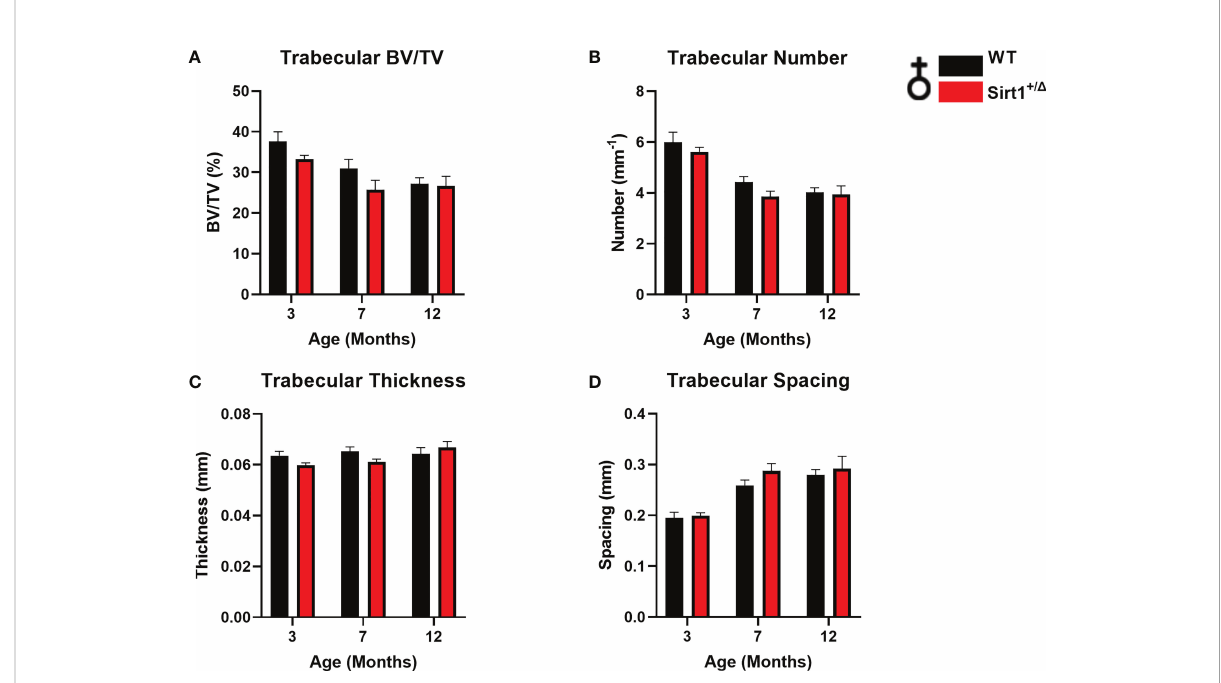
FIGURE 2 The effects of Sirt1 haploinsuf fi ciency on vertebral L4 trabecular bone indices in female mice. µCT analysis of L4 trabecular bone in 3, 7,12- month-old Sirt1 +/ D and WT female mice. (A) Bone volume fraction (BV/TV%) (B) Trabecular number (C) Trabecular thickness (D) Trabecular spacing. Results are Mean ± SEM analyzed by unpaired Student ’ s t test (n = 7-11